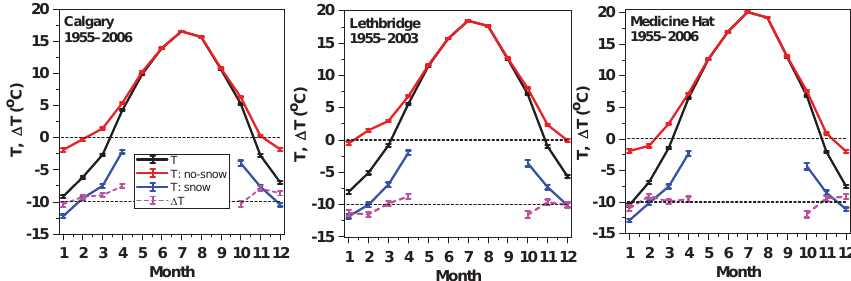
Figure 2. Annual Climatology for Calgary, Lethbridge and Medicine Hat, with the separation into days with and without snow cover.